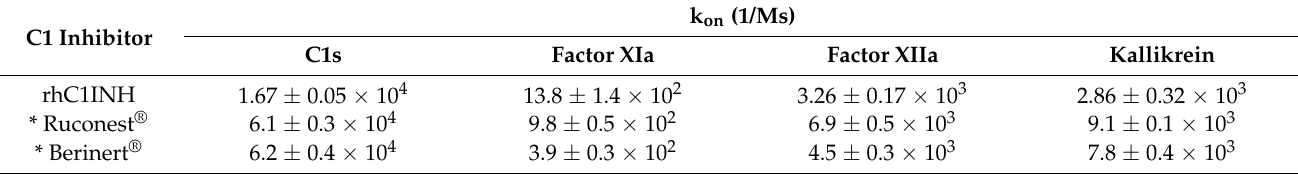
Table 9. Comparison of association with proteases.